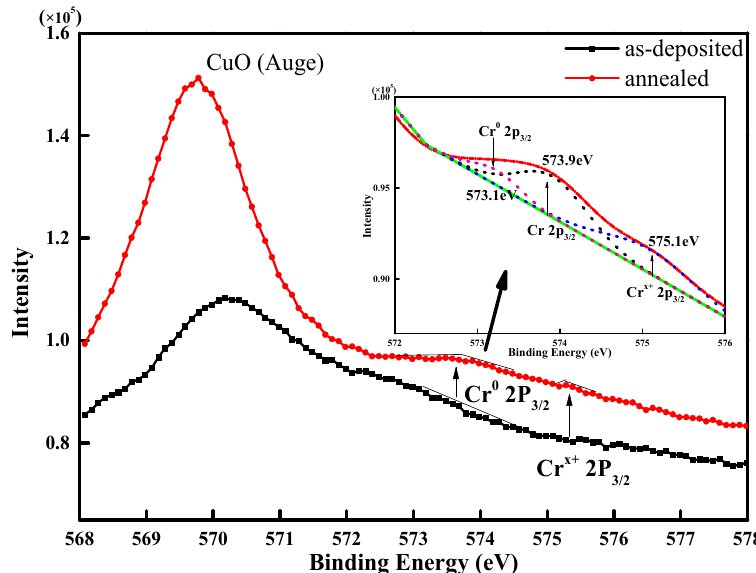
Figure 4. XPS spectra of Cr2p core levels on the Cu-Cr-Zr thin film surface before and after annealing. The spectrum of annealed sample (circle dots) was fitted by the Shirley background (dashed line) and fitted with peaks of Cr2p3/2 (573.1 eV), Cr2p3/2 (573.9 eV), and Cr2p3/2 (575.1 eV) (dotted line).